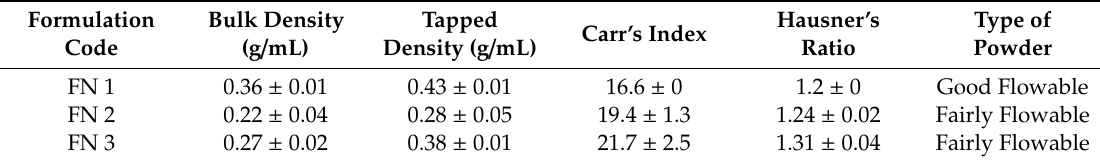
Table 2. Representing the micromeritic properties of various proniosomal powder formulations, which includes the bulk and tapped density of all formulations and their corresponding flowability according to the Carr’s Index and Hausner’s